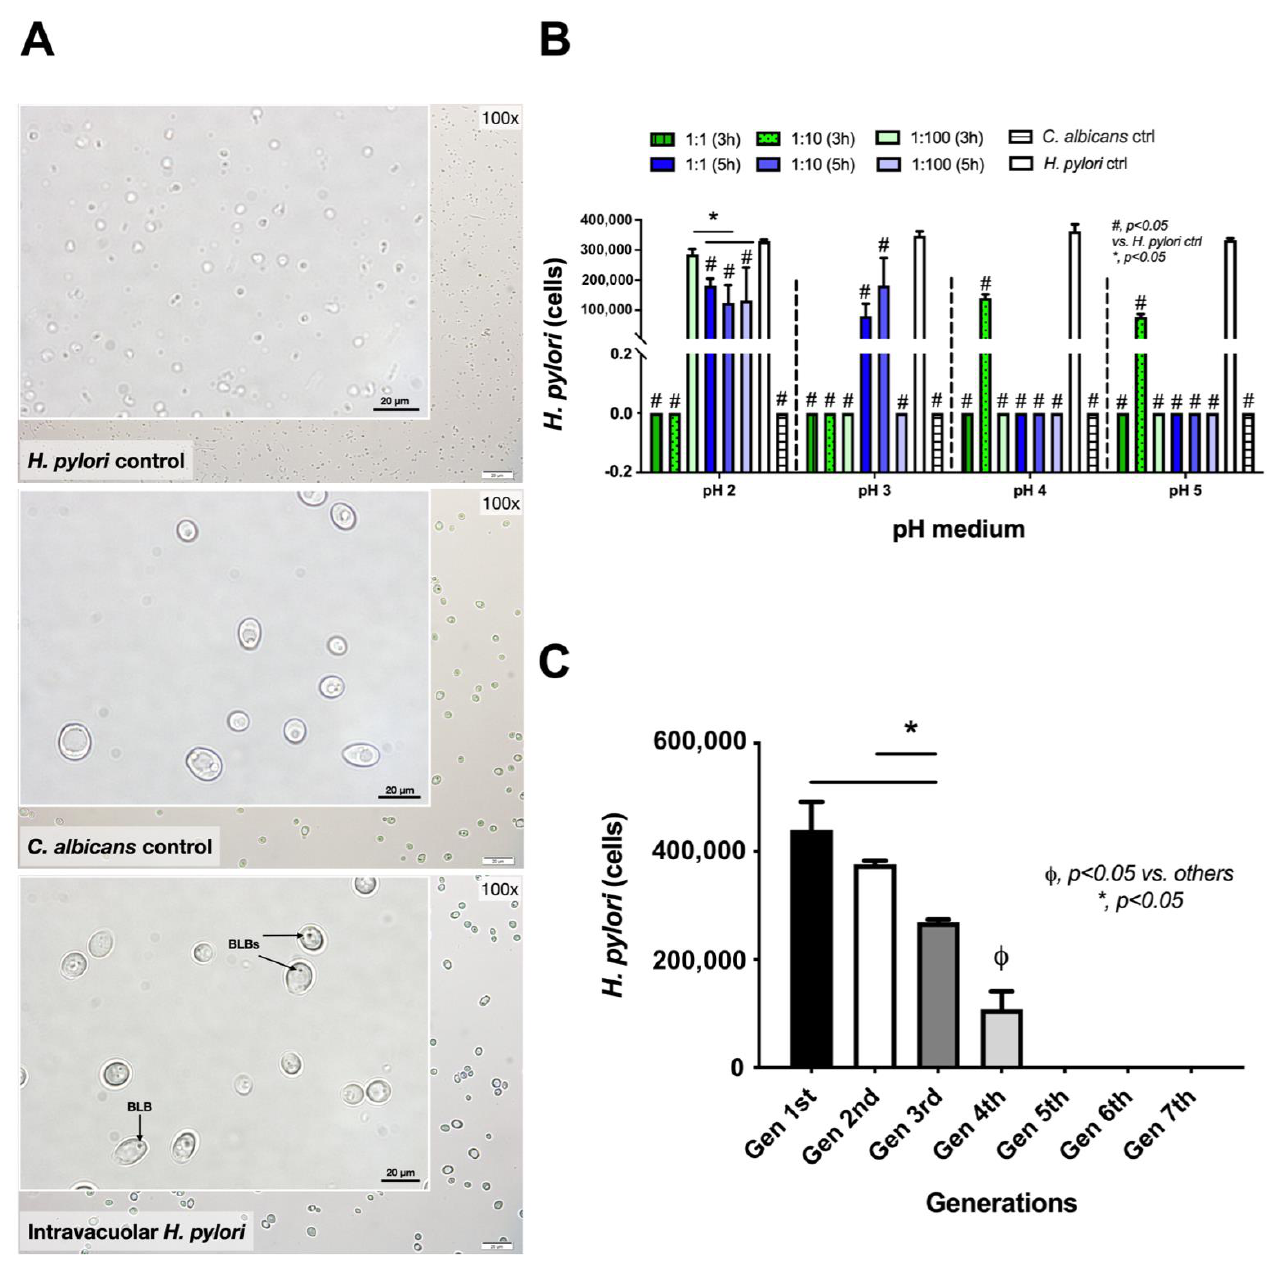
Figure 2. Characteristics of intravacuolar H. pylori inside Candida yeast cells under a bright-field microscope, 10 fields/slide (100× magnification), compared with the controls H. pylori and C. albicans alone ( A ). The real-time polymerase chain reaction (PCR) based on CagA gene expression demon- strates intravacuolar H. pylori in different conditions (the H. pylori vs. Candida ratio, pH media, and duration of incubation) compared with control ( B ). Intravacuolar H. pylori in each generation after the sub-culture of Candida yeast cells ( C ) (n = 9/group). Independent triplicate experiments were performed. *, p < 0.05; ϕ , p < 0.05 vs. others; BLBs, bacteria-like bodies; ctrl, control; Gen,